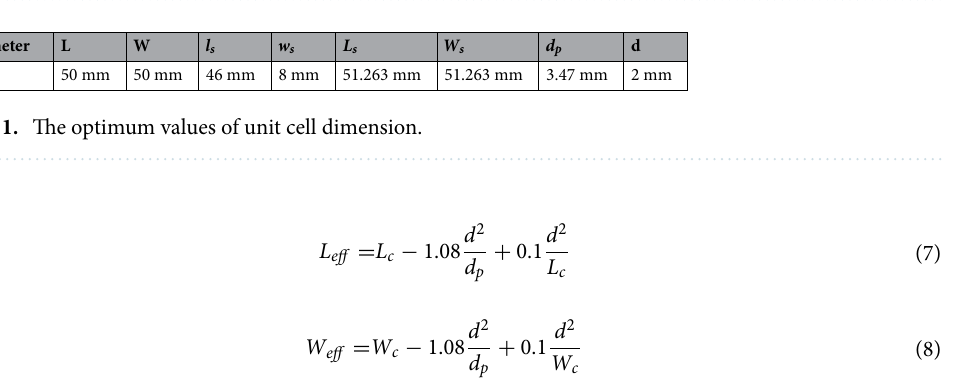
Figure 4. The effects of via hole parameters on absorption characteristics ( a ) Hole’s diameter, ( b ) Hole’s distance.